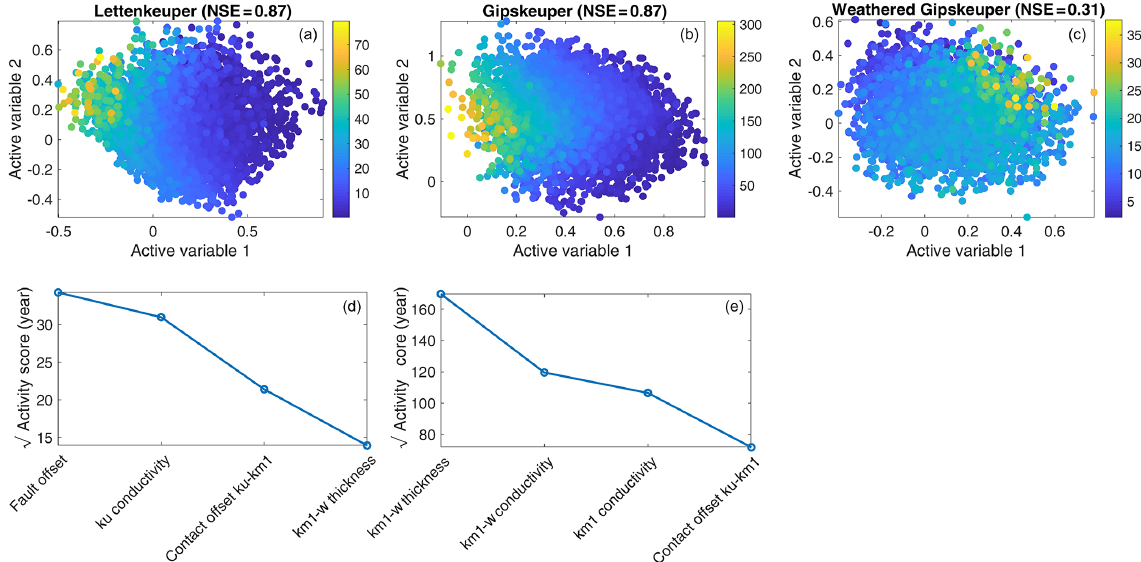
Figure 8. Two-dimensional active subspaces (a–c) and square root of activity scores (d, e) for residence time (years) in three geological units. Please note that the activity-score plots are limited to the four most important parameters and that due to the poor active-subspace decomposition, this plot is not shown for the last